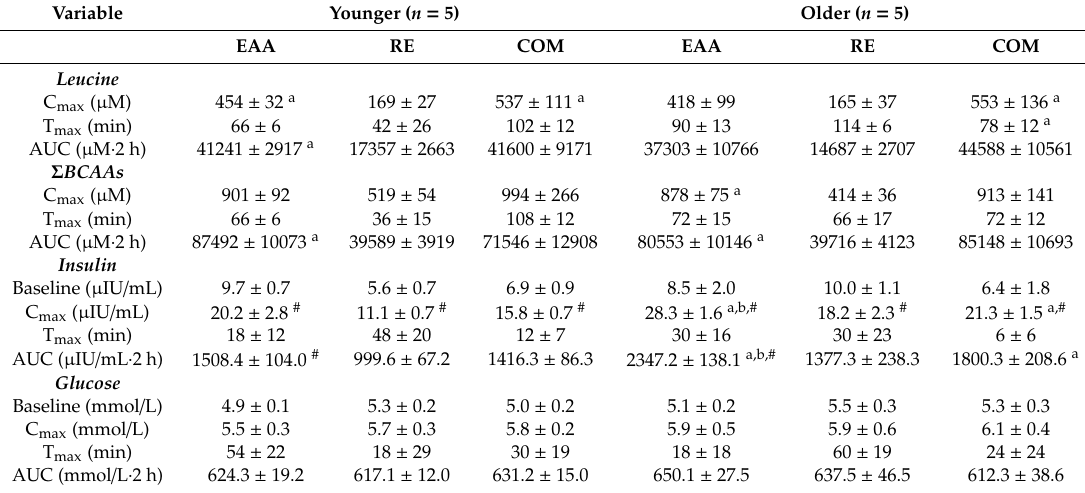
Table 3. Plasma leucine, branched-chain amino acid, insulin, and glucose concentrations in younger and older adults for each